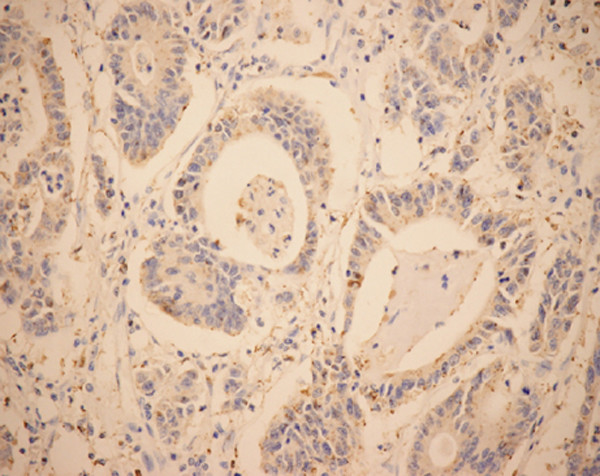
Immunohistochemical staining of HIF-1α in moderately differentiated colon adenocarcinomas (EnVision, ×200). Typical mixed nuclear/cytoplasmic immunostaining of HIF-1α.